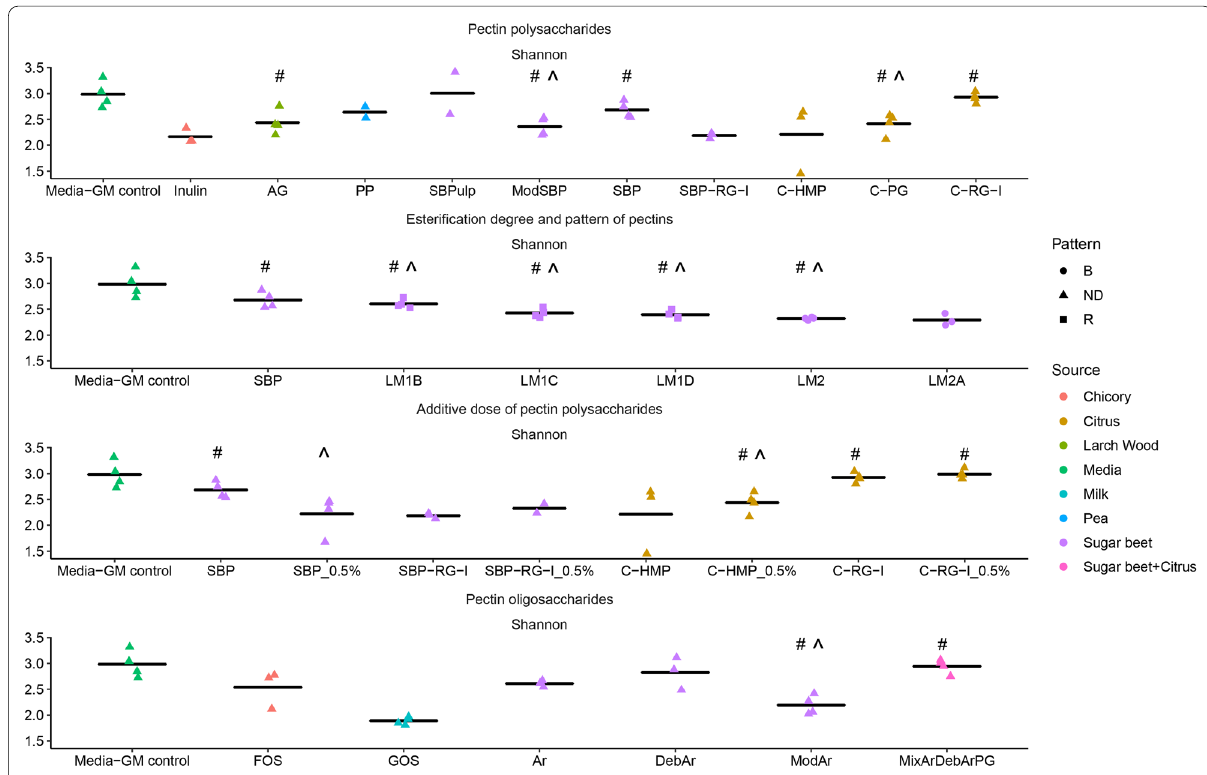
Fig. 2 The effect of substrate on Shannon diversity index of in vitro simulated piglet gut microbiota as determined by 16S rRNA gene (V3-region) amplicon sequencing. The additive dose is 1% except for groups with specific description of using 0.5% dose. The data shown are averages of 4 replicates, unless otherwise stated. a Polysaccharides sourced from pectins with inulin (n 3) and AG (arabinogalactan) as prebiotic controls. PP pea = pectin (n 2), SBPulp pulp from sugar beet (n 2), ModSBP modified sugar beet pectin, SBP sugar beet pectin, SBP_RG-I sugar beet pectin derived = = rhamnogalacturonan I (n 3), C-HMP citrus derived high methoxyl pectin(n 3 for 1% dose), C-PG citrus-derived polygalacturonic acid (constituting = = pectins through methyl esterification), C-RG-I citrus derived rhamnogalacturonan I; b sugar beet pectins with different degrees and patterns